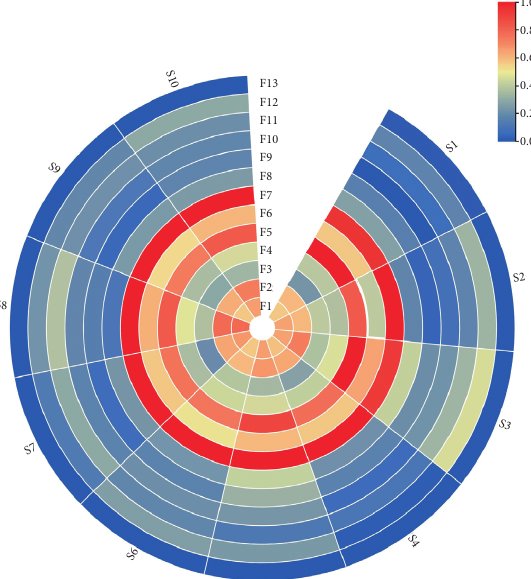
Figure 6: Heatmap of peak areas from 10 batches of samples by 0-1 normalization.